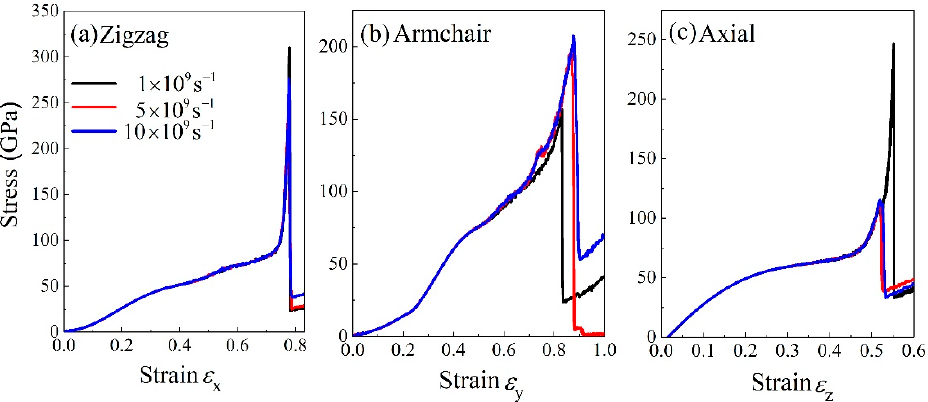
Figure 7. The stress-strain curves of BNHCs under tensile loading at various stain rates along ( a ) zigzag, ( b ) armchair and ( c ) axial directions, respectively.